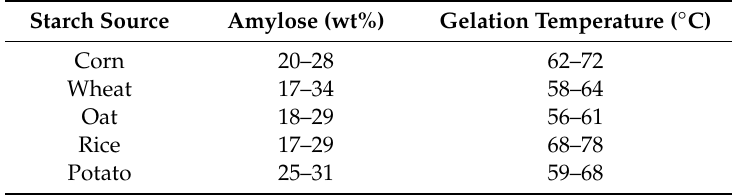
Figure 1. Starch structure, ( a ) amylose and ( b ) amylopectin. Table 1. Amylose content and gelation temperature of different starch types.